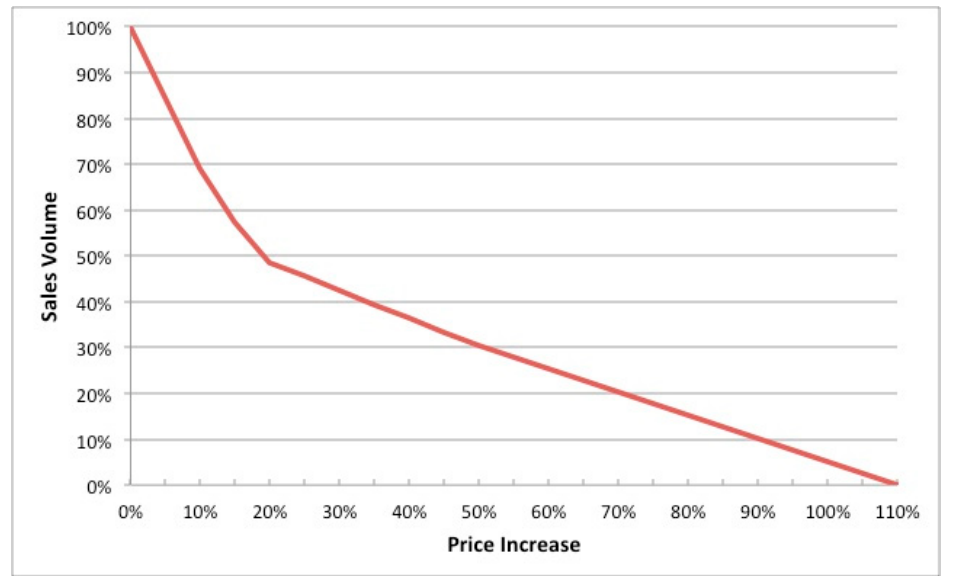
Figure 7. The relationship of sales volume and price, for the scoring of Plan D and E.